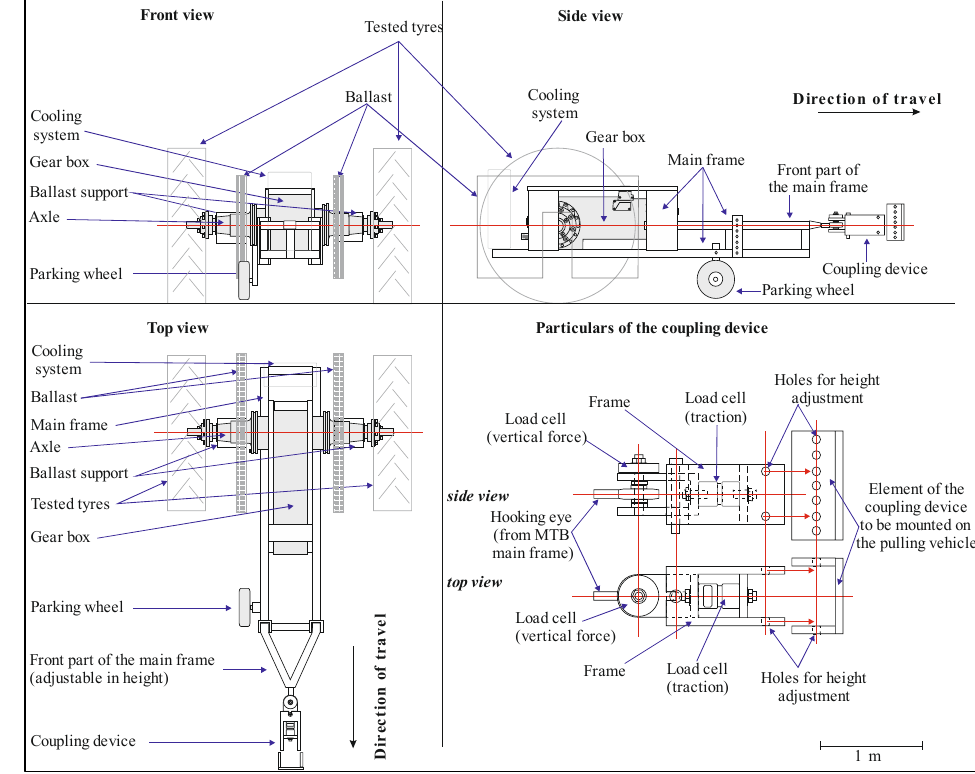
Figure 2. Schemes of the MTB frame and ballast and particulars of the coupling device.